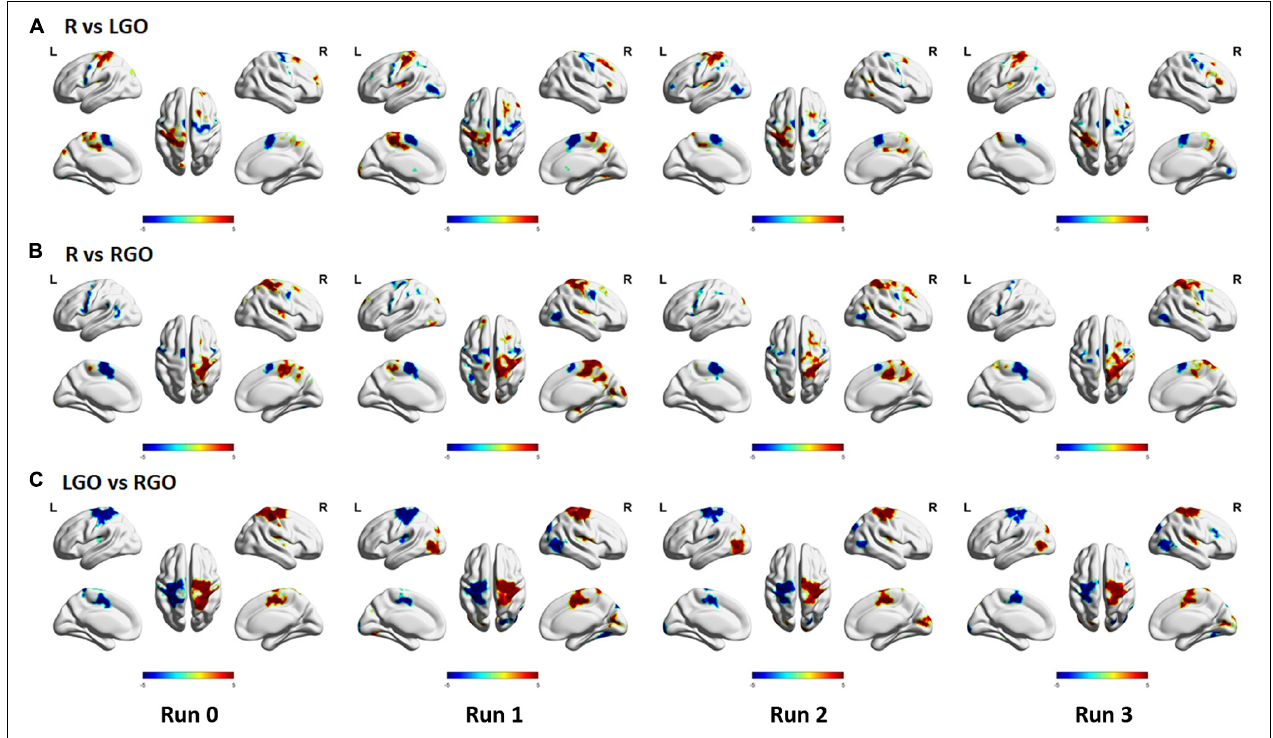
FIGURE 6 | Significant weights (FWEc p < 0.05 with CDT p = 0.001) of the different SVM classification models obtained using a one-sample t -test of the SVM weights from all participants: (A) R vs. LGO, (B) R vs. RGO, and (C) LGO vs. RGO. Red–yellow color map indicates that the activity during rest (R) is higher compared to that during task (LGO/RGO) in R vs. LGO and R vs. RGO models and higher during LGO task compared to that during RGO task in LGO vs. RGO model. Blue–light blue color map indicates the opposite.